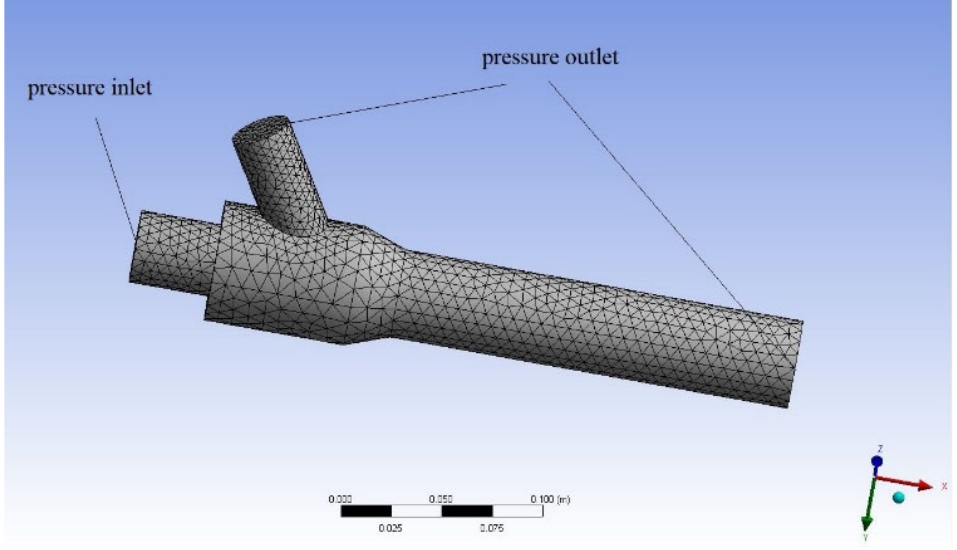
Figure 5. Boundary conditions and mesh division of the venturi seed supply pipe.